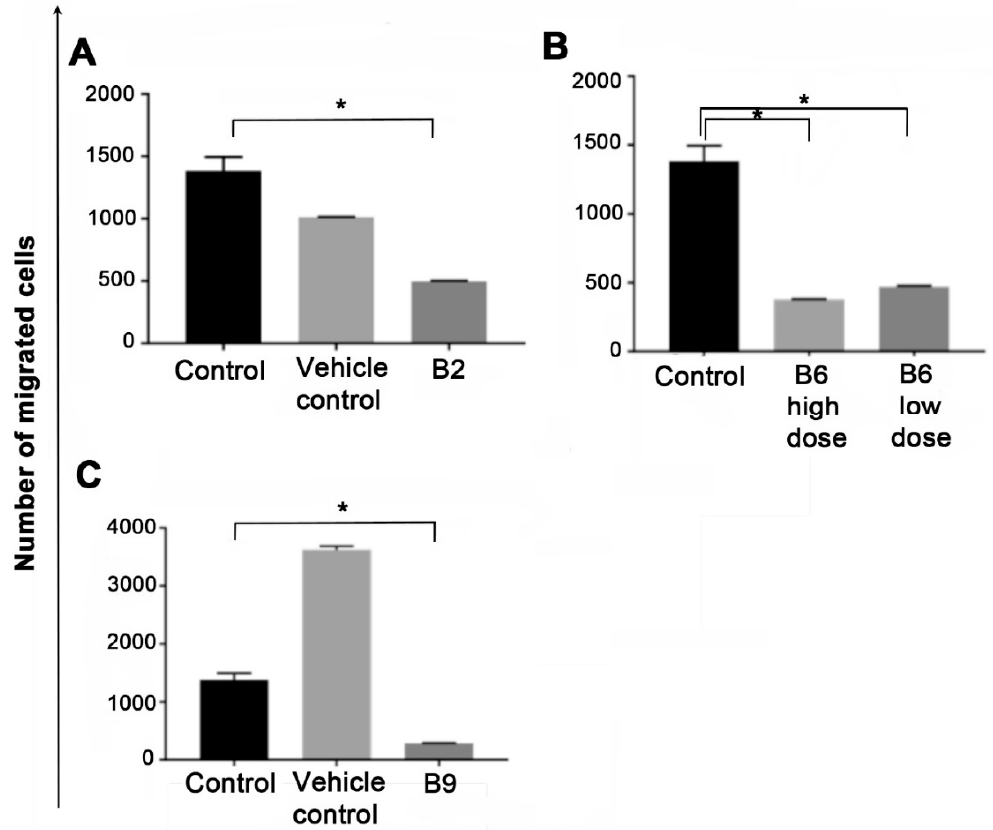
Figure 3. Effect on cell migration of pro-monocytic cells in the presence of ( A ) vitamin B2 (riboflavin), ( B ) vitamin B6 (pyridoxine) and ( C ) vitamin B9 (folic acid) using Boyden chamber assay. Data (